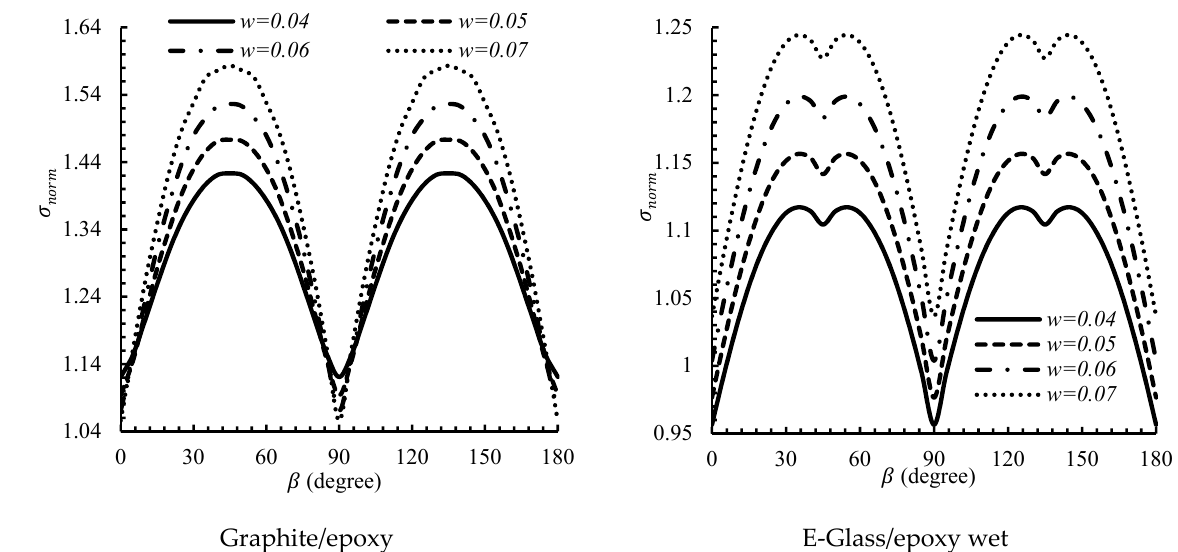
Figure 6. Effect of hole orientation on the maximum normalized stress in different values of w.